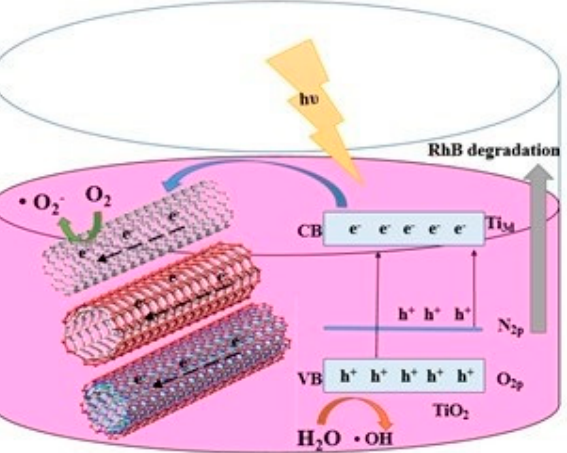
Scheme 2. The mechanism of RhB photocatalytic degradation in the presence of the TiO 2 :N/CNT